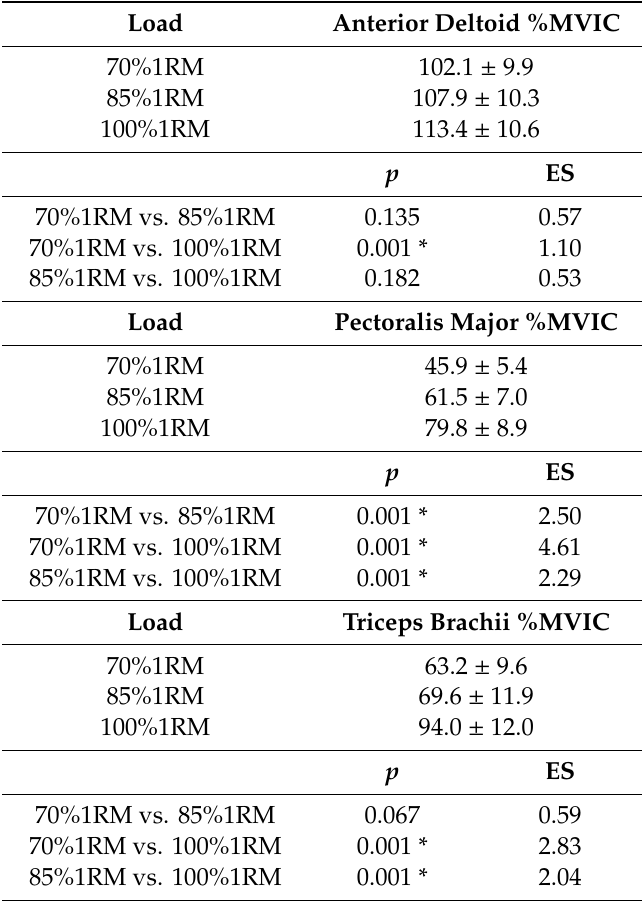
Table 4. Post hoc analysis for the main interaction of three loads vs. three muscle